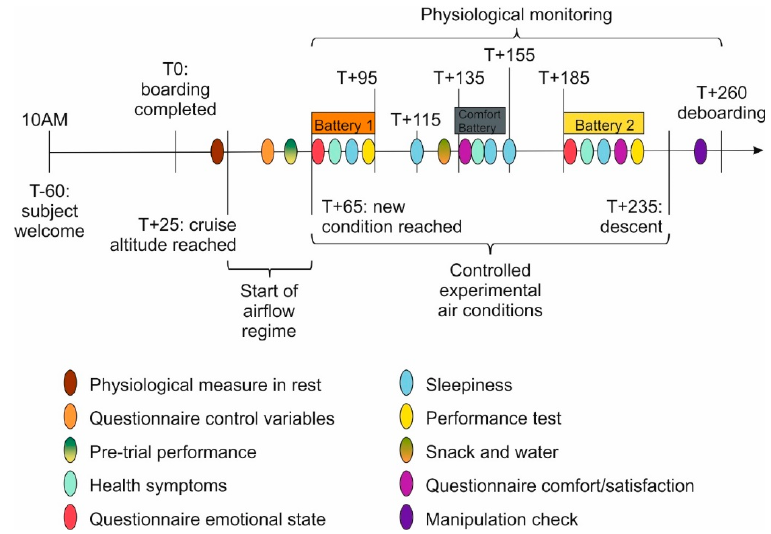
Figure 3. Test sequence.